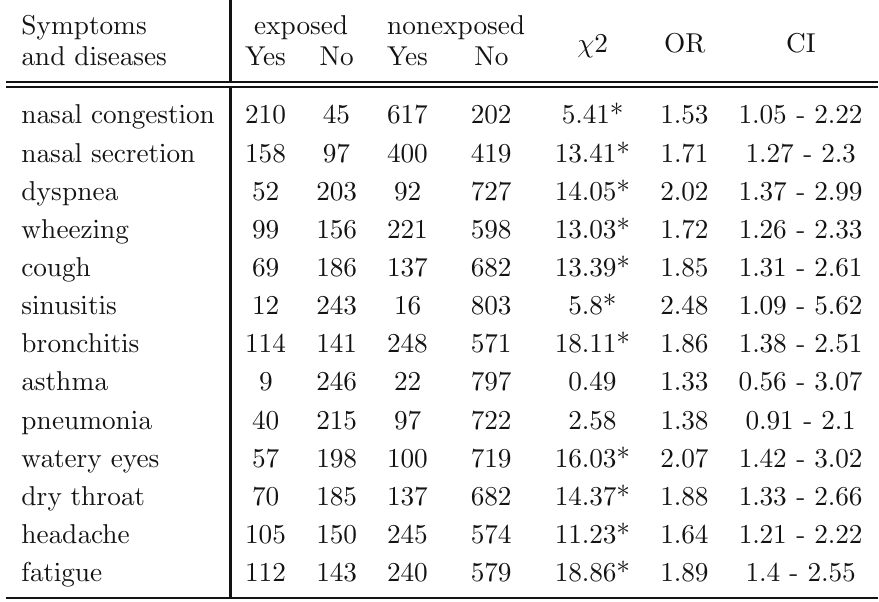
Table 7 Exposure to insects and rats allergens and its influence on children’s health.